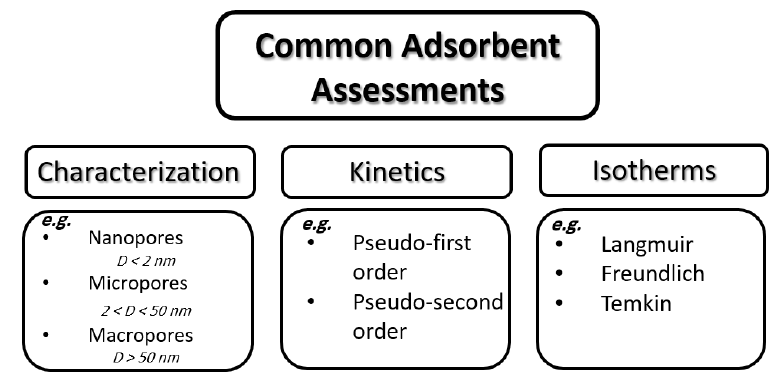
Figure 1. Common parameters for describing adsorption systems in the literature.